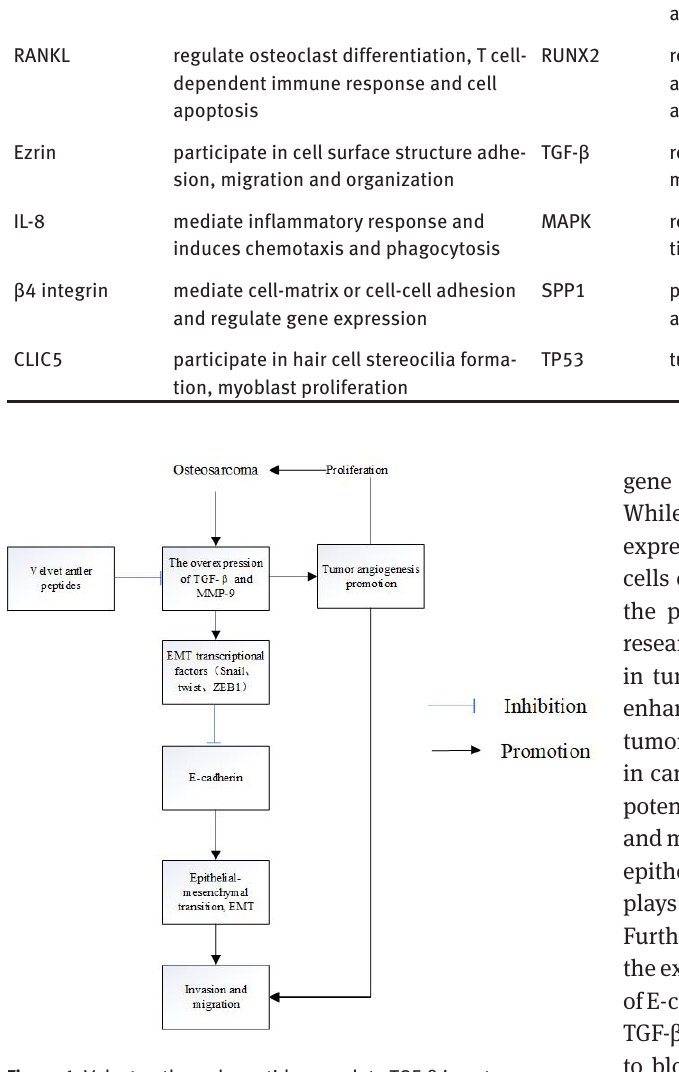
Figure 1: Velvet antler polypeptides regulate TGF-β in osteosarcoma cells. Note: The VAP inhibit the expression of EMT transcriptional factors and E-cadherin by down-regulating the TGF-β pathway in MG-63 cells, which interfere the invasion and migration